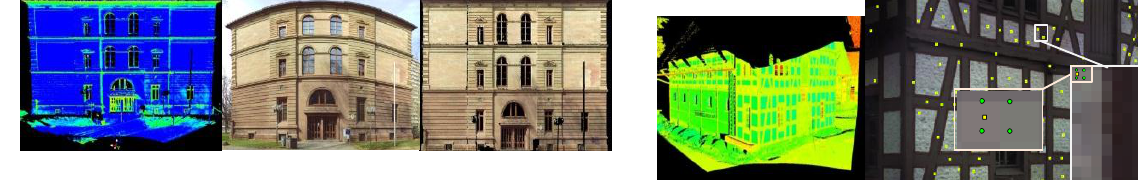
Figure 2. Dataset of Stuttgart University building, (from the left) 3D laser point cloud, RGB image of Faro Focus 3D and our generated RGB image Figure 4. Old farm dataset, 3D laser point cloud (left) and the matched features on the RGB image (right). In close, the nearest neighbors (green) used to interpolate the corresponding object coordinates for each feature